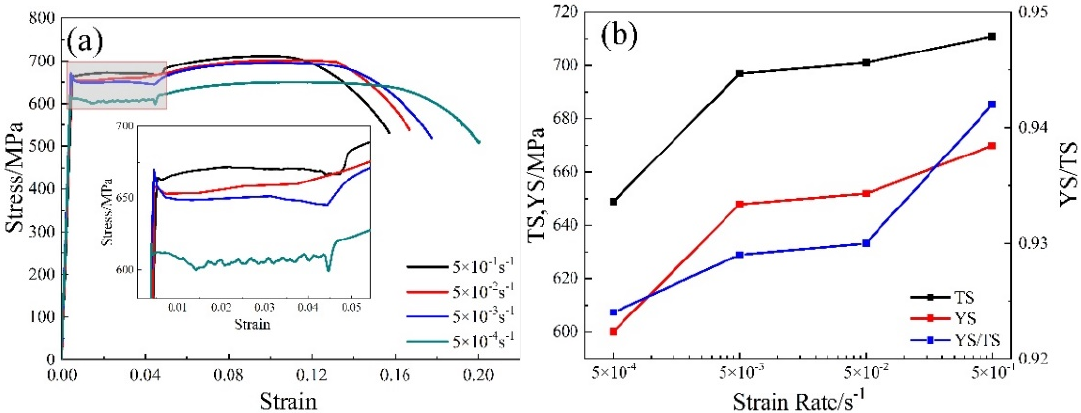
Figure 8. Stress–strain curve ( a ) and intensity change ( b ) of annealed samples under different strain rate of AR2. It can be seen from Figure 8b that the yield strength and tensile strength increased rapidly as the strain rate increased from 5 × 10 − 4 s − 1 to 5 × 10 − 1 s − 1 , then the